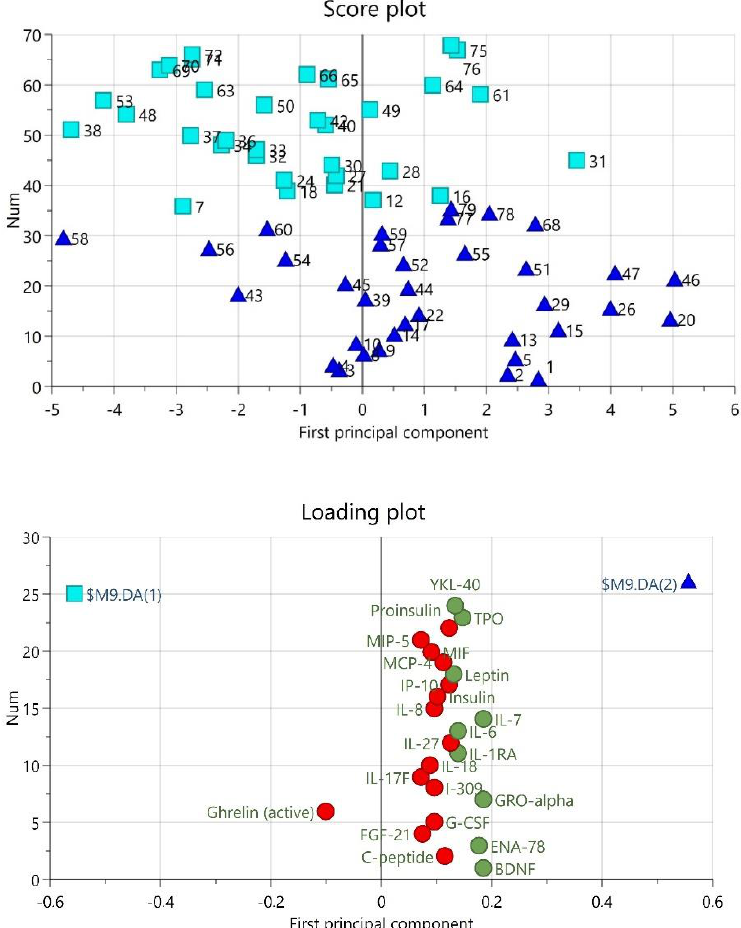
Figure 1. Orthogonal partial least square discriminant analysis (OPLS-DA) of patients with myoge-